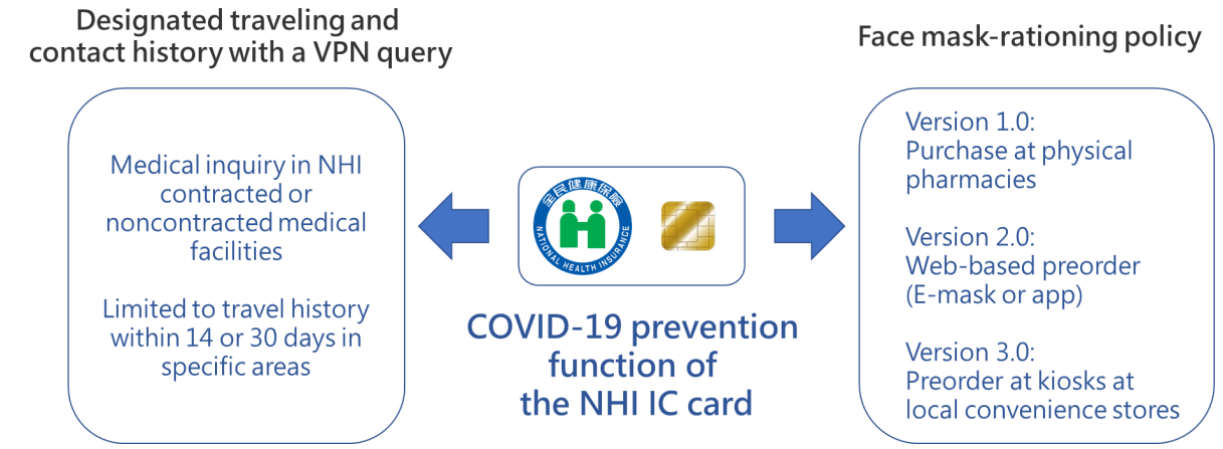
Figure 1. Diagrammatic representation of the NHI IC card usage in COVID-19 prevention policies. NHI: National Health Insurance, VPN: virtual private